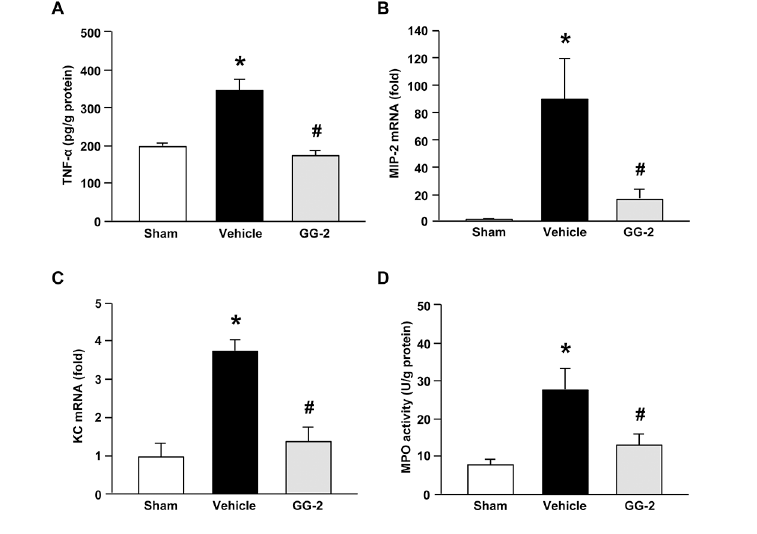
Figure 5. Effect of the combined treatment on liver inflammation in aged septic rats. Rats were sham operated or subjected to CLP with injection of vehicle (normal saline) or GG-2 (80 nmol/kg of ghrelin and 50 μ g/kg of GH) at 5 h after CLP. The liver tissues